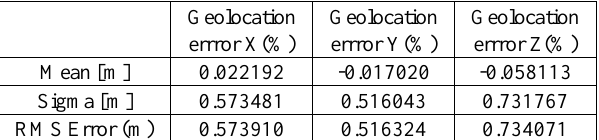
Table 3. Geolocation errors, point cloud from Feb 20, 18.